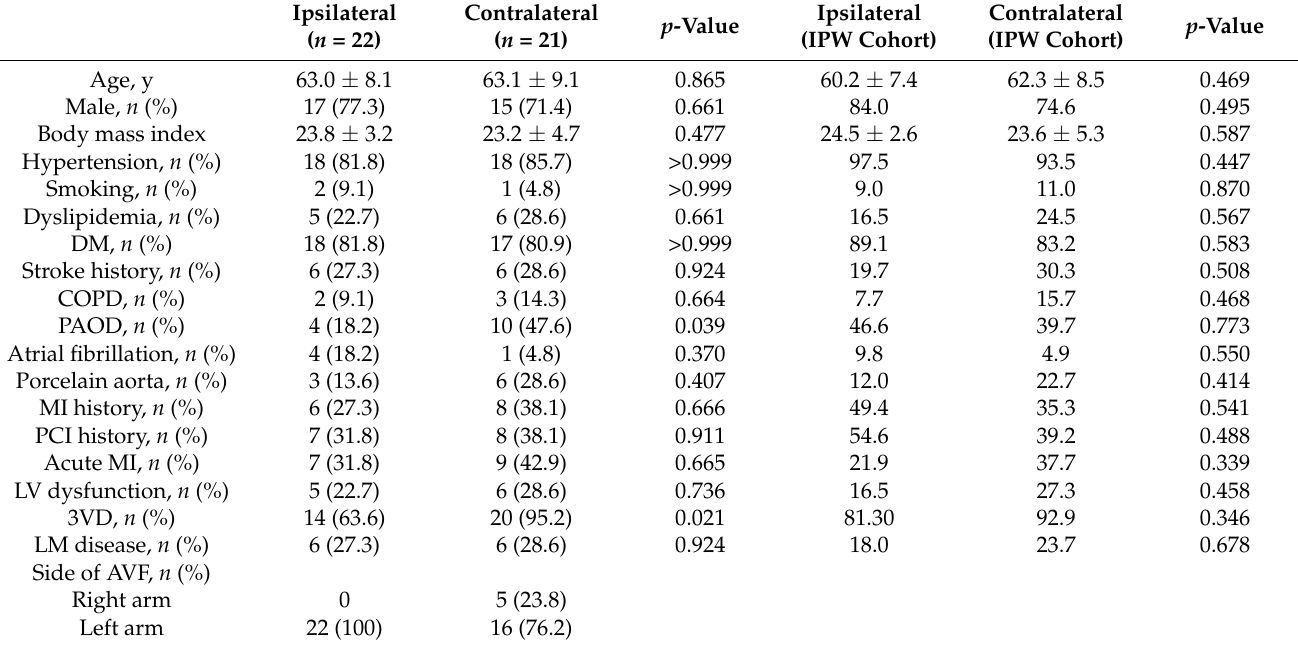
Table 1. Patient characteristics.